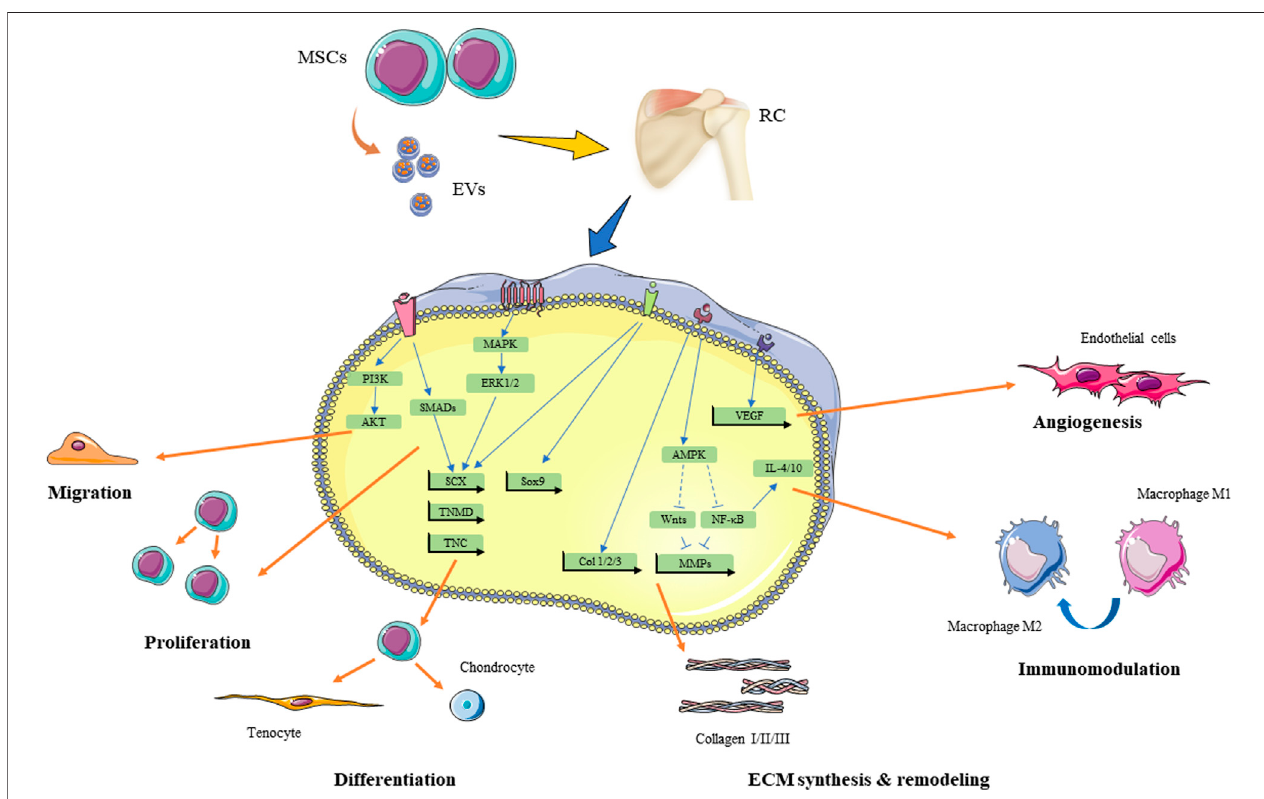
FIGURE 2 | Theraputic effect of MSCs and MSC-EVs for rotator cuff injuries and underlying signaling pathways. RC, rotator cuff; MSCs, mesenchymal stem cells; EVs, extracellular vesicles; MAKP, mitogen-activated protein kinase; ERK, extracellular signal-regulated kinases; PI3K, phosphoinositide 3-kinase; SCX, scleraxis; TNMD,tenomodulin;TNC,tenascinC,Sox9,SRY-Boxtranscriptionfactor9;Runx2,runt-relatedtranscriptionfactor2;AMPK,5 ′ AMP-activatedproteinkinase;NF- κ B, nuclear factor kappa B; MMPs,matrix metalloproteinases; IL, interleukin. ECM, extracellular